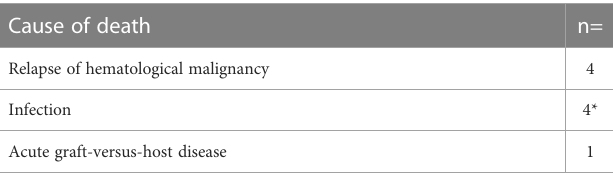
FIGURE 3 Overall survival (OS) after MSC therapy.